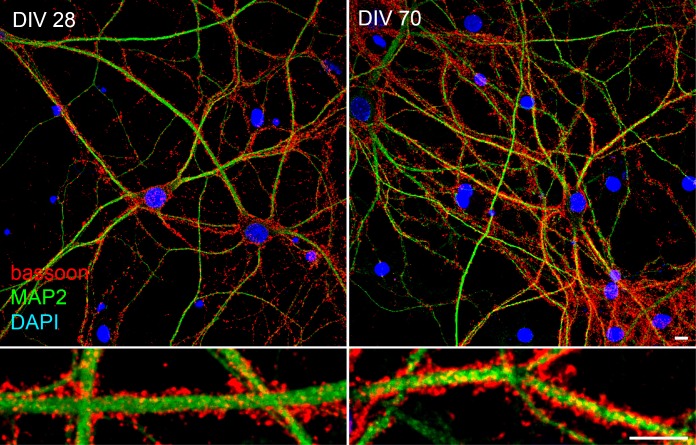
Viable hippocampal neurons can be maintained in culture for more than two months.Labeling of dendrites (MAP2, green), synapses (bassoon, red) and nuclei (DAPI, blue) in DIV28 and DIV70 neurons documenting the viability of DIV 40 and older neurons as in Figure 1. Scale bar 10 μm.